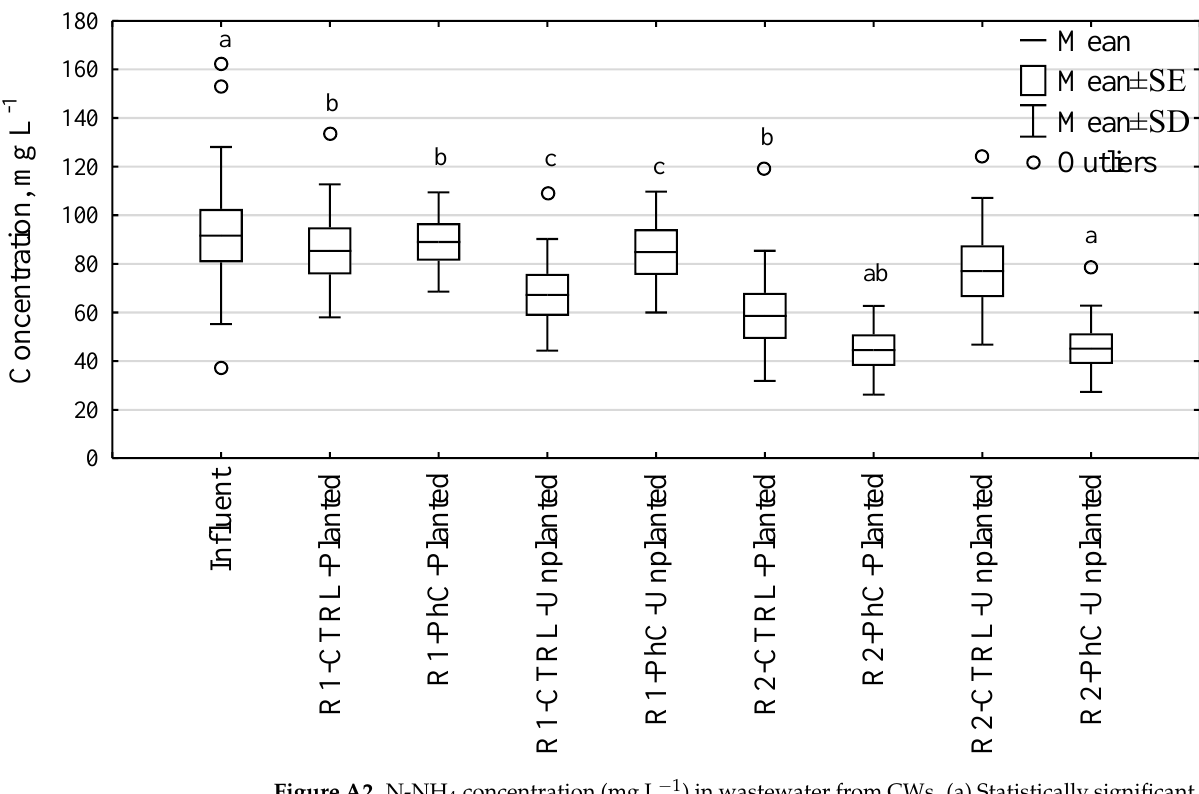
Figure A2. N-NH 4 concentration (mg L − 1 ) in wastewater from CWs. (a) Statistically significant differences between the wastewater influent and effluent (Mann-Whitney U test, p < 0.05); (b) Statistically significant differences between counterpart types of columns (CTRL or PhC) with different frequency of wastewater dosing (Mann-Whitney U test, p < 0.05); (c) Statistically significant differences between control wastewater and wastewater containing pharmaceuticals (Mann-Whitney U test, p < 0.05). According to Li et al. [55], pharmaceuticals removed via CWs can be classified as easily removable (removal rate > 70%), moderately removable (50–70%), not-easily removable (20–50%) and almost non-removable (removal rate < 20%). According to this classification, DCF may be classified as a moderately removable compound (on average 61.5% removal), whereas SMX was easily removable by CWs treatment (on average 88.4% removal). Table A5. Activity of antioxidant enzymes in M. giganteus .